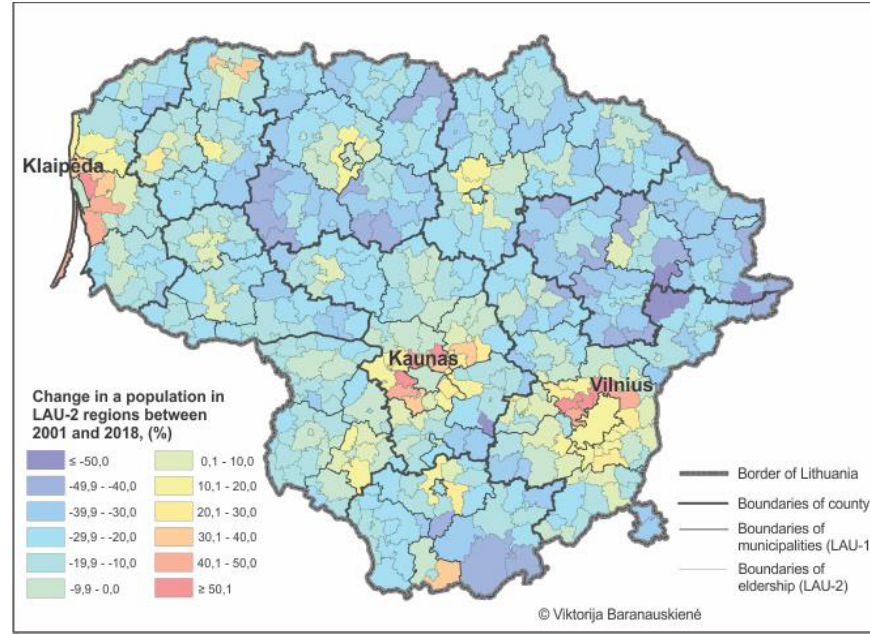
Fig. 1. Population change in Lithuania and sprawling metropolitan areas, 2001–2018 (Source: Created by V. Baranauskienė based on data from the Centre of